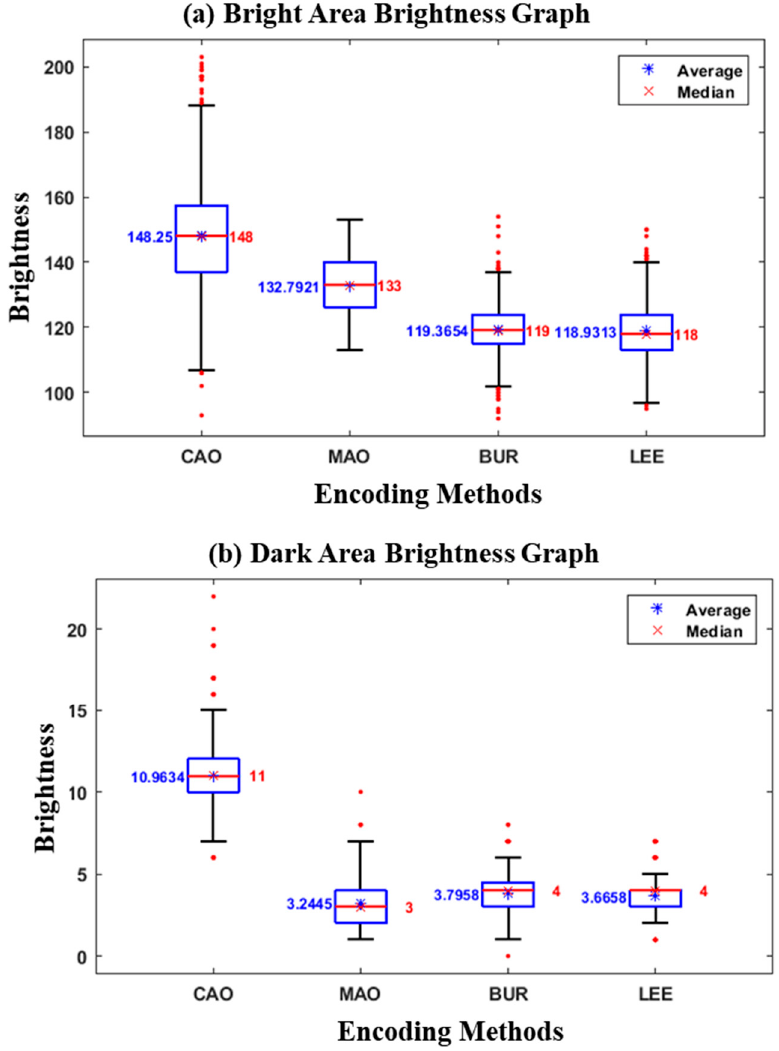
Figure 12. Intensity measurement of ( a ) bright area and of ( b ) dark area in H3D images optically reconstructed using four kinds of encodings.